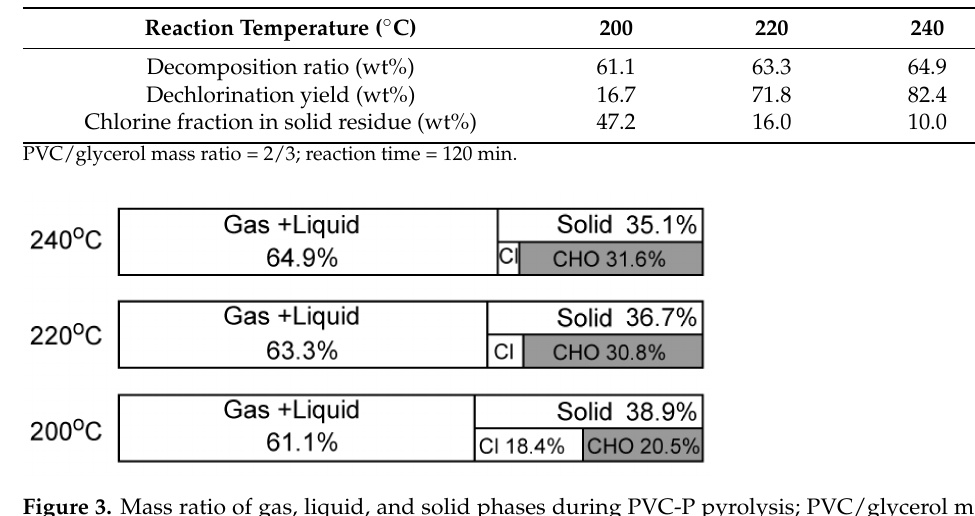
Figure 3. Mass ratio of gas, liquid, and solid phases during PVC-P pyrolysis; PVC/glycerol mass ratio = 2/3, reaction time = 120